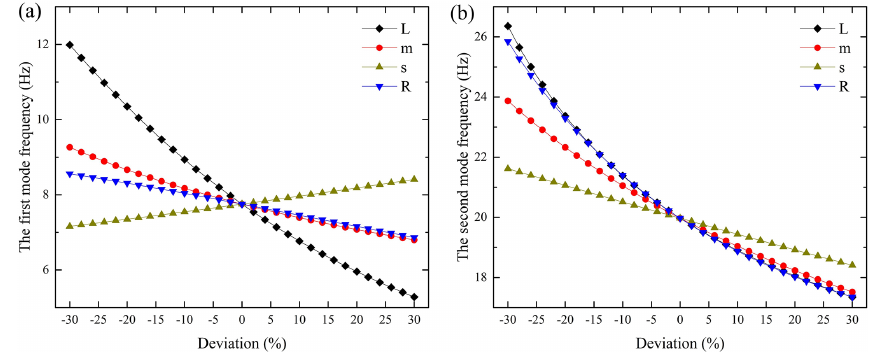
Figure 5. Variations of the natural frequencies with the changes of vibration damper’s structural parameters: (a) the first-order natural frequency, (b) the second-order natural frequency.